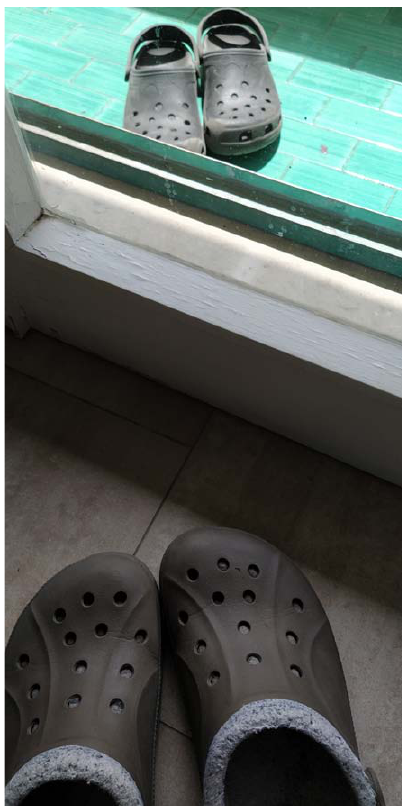
Figure 2. Pantofole di lana e zoccoli estivi in dialogo attraverso una porta, 2020; © Mariella